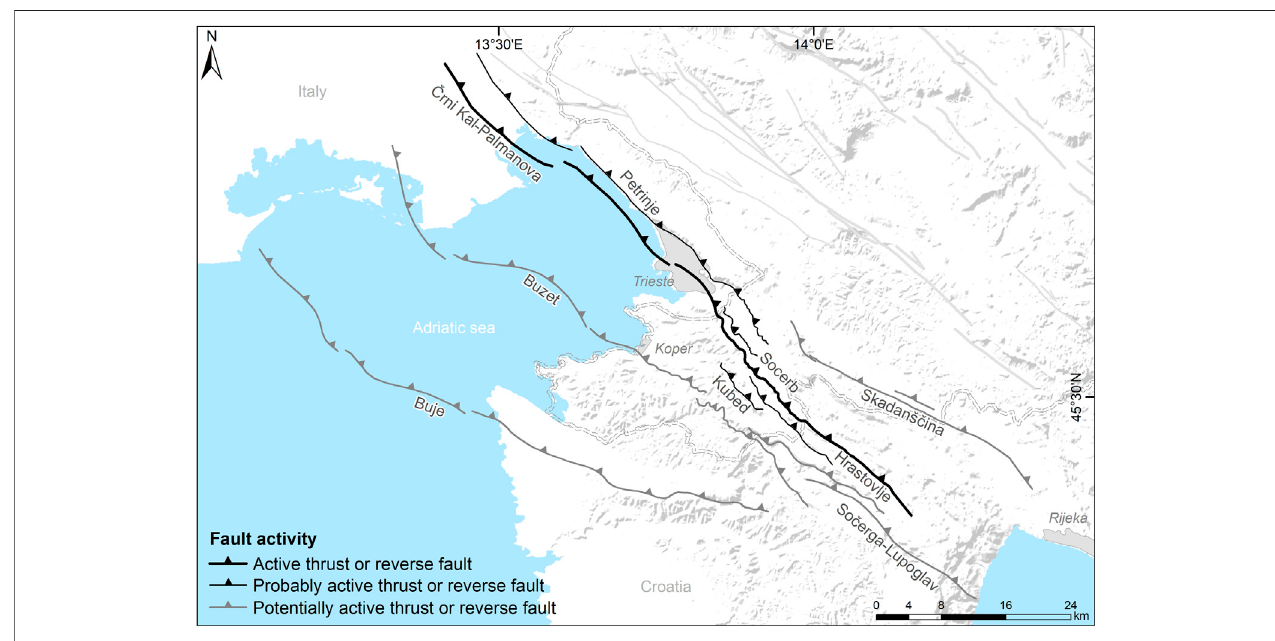
FIGURE 5 | Adriatic foreland fault system. The system comprises a thrust belt approximately 30 km wide. The dominant active fault is the ˇ Crni Kal – Palmanova thrust.